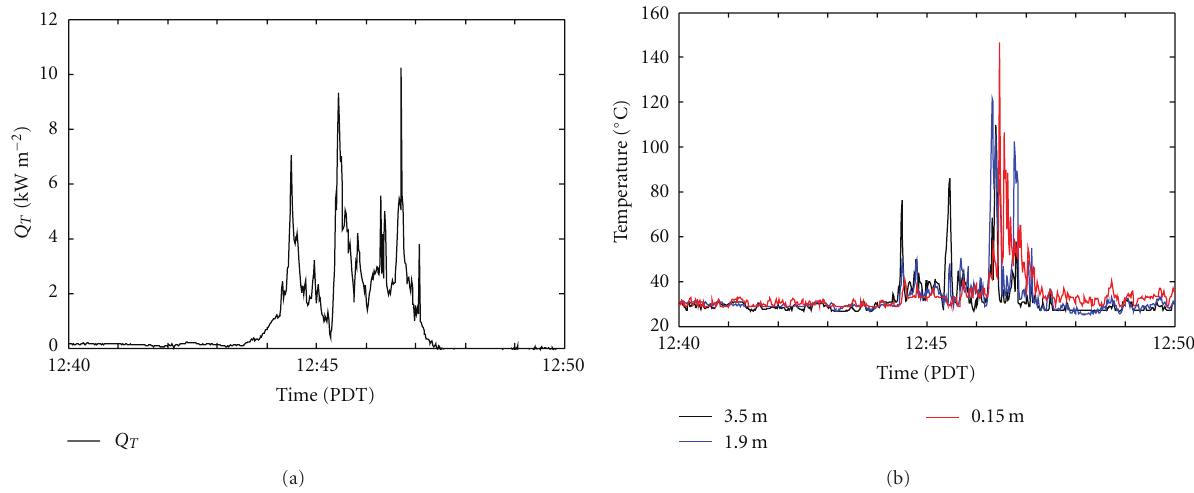
Figure 11: Time series of 1-s averaged (a) total heat flux, Q T , and (b) thermocouple temperatures, T c , at di ff erent levels on the interior tower.